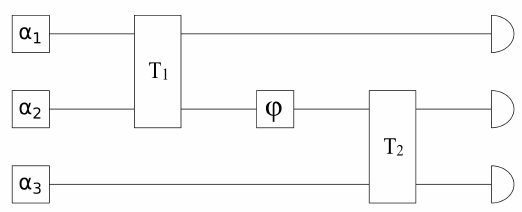
Figure 4. Optimal joint estimation scheme for three modes using two beam splitters of transmittance T 1 and T 2 and a phase shifter of angle φ